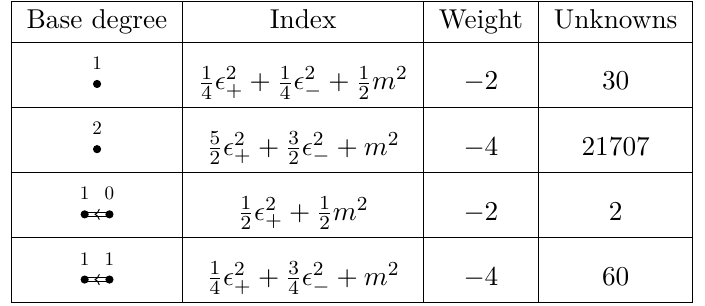
Table 6 . The index polynomial, weight and unknown coefficients for the numerator of the ( C r ) π elliptic